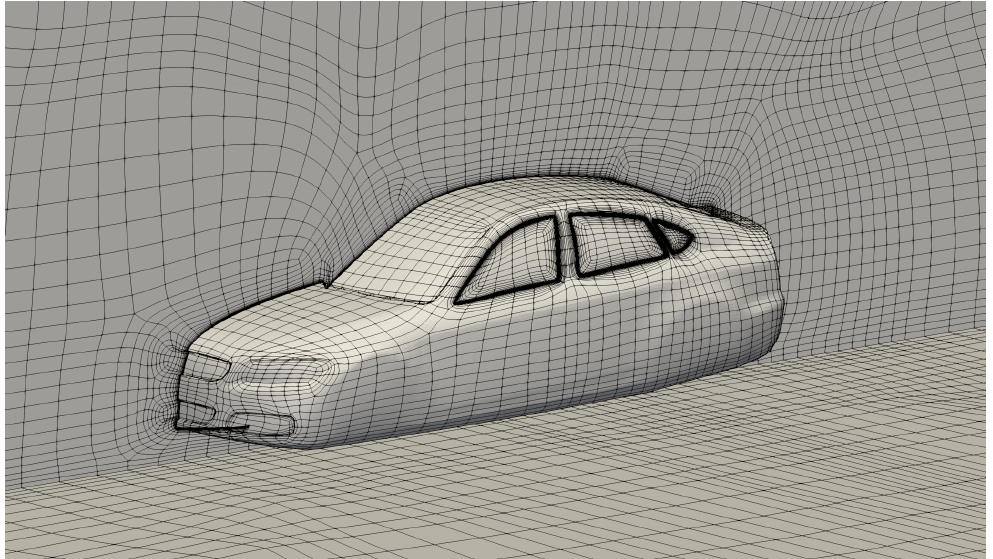
Figure 6. Simplified DrivAer model—Surface mesh of the DrivAer model, 113,780 cubic-edges hexahedral